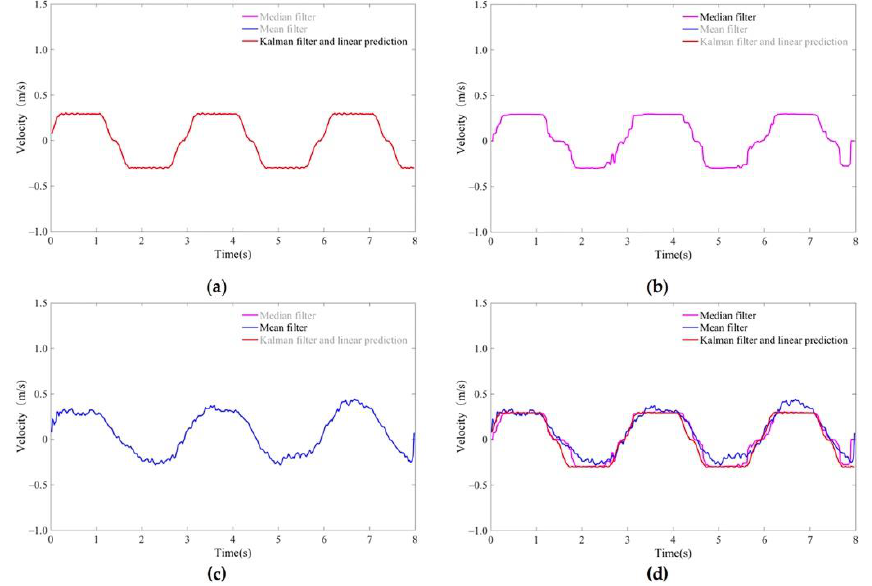
Figure 7. Velocity measured by CHDSF using the Kalman filter and linear prediction, median filter and mean filter: ( a ) velocity measured by CHDSF using the Kalman filter and linear prediction; ( b ) velocity measured by CHDSF using median filter; ( c ) velocity measured by CHDSF using mean filter; ( d ) comparison of velocities measured by CHDSF using 3 filters.